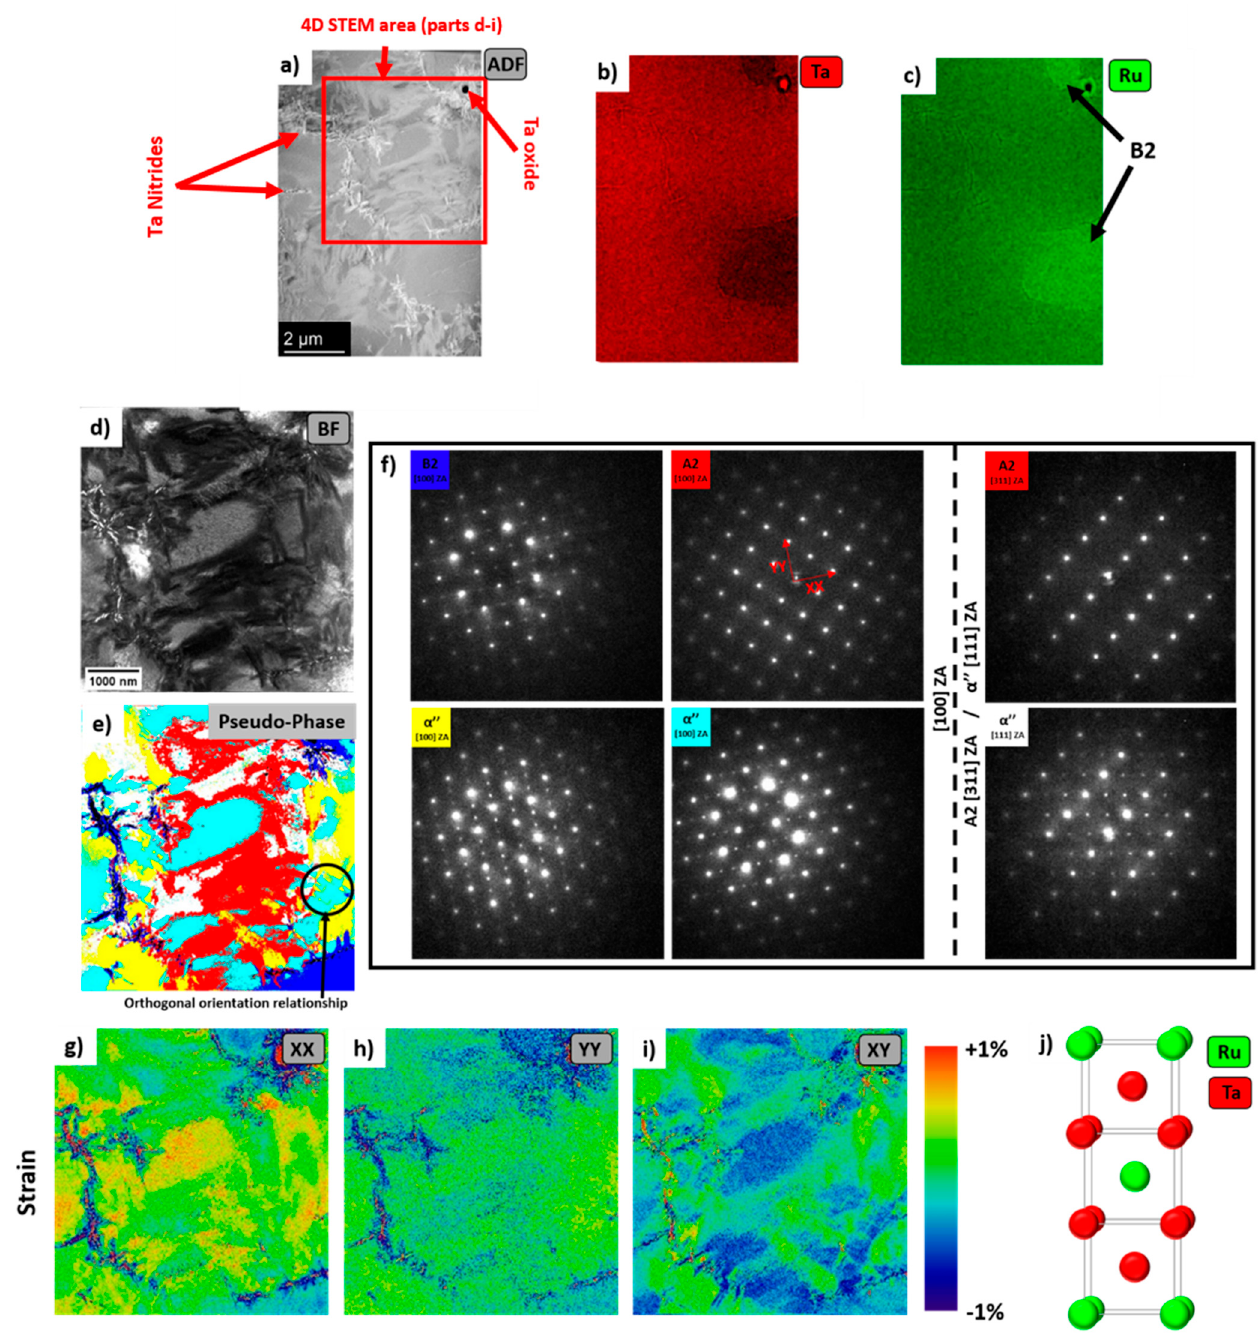
Figure 4. TEM analysis of the aged Ta72Ru28 alloy. ( a ) ADF and ( b – c ) elemental maps. ( d ) virtual BF produced from 4D pencil beam STEM, ( e ) pseudo phase map of the region shown in ( d ), representative diffraction patterns for each colour are shown in ( f ). Blue=B2, yellow, cyan and white= α ’’ and red=A2. ( g – h ) normal and ( i ) shear strain maps relative to the A2 phase of the region shown in ( d ), the reference directions are shown in ( f ). The XX and YY directions are parallel to the c axis in the cyan and yellow orientations of α ’’, respectively. ( j ) the proposed crystal structure of the α ’’ phase. Within both lamellae, with the exception of some slight bending and the oxide/nitride phases, all the phases were fully coherent with each